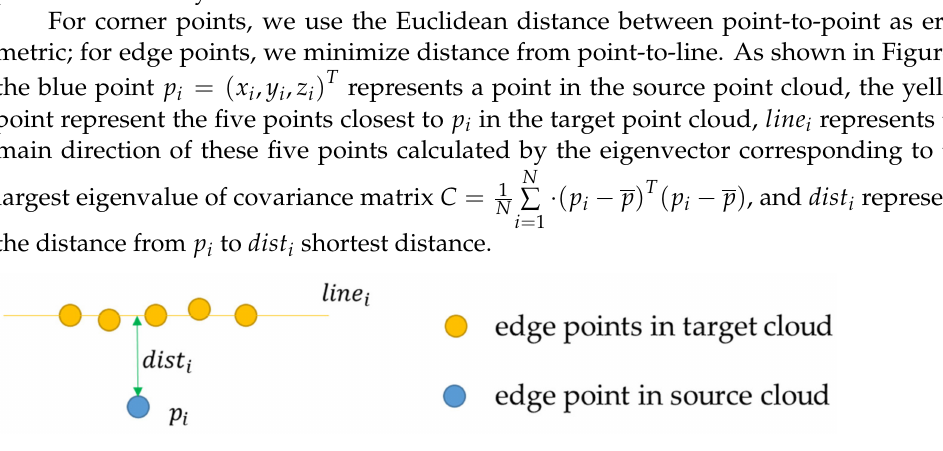
Figure 5. Error metric for edge